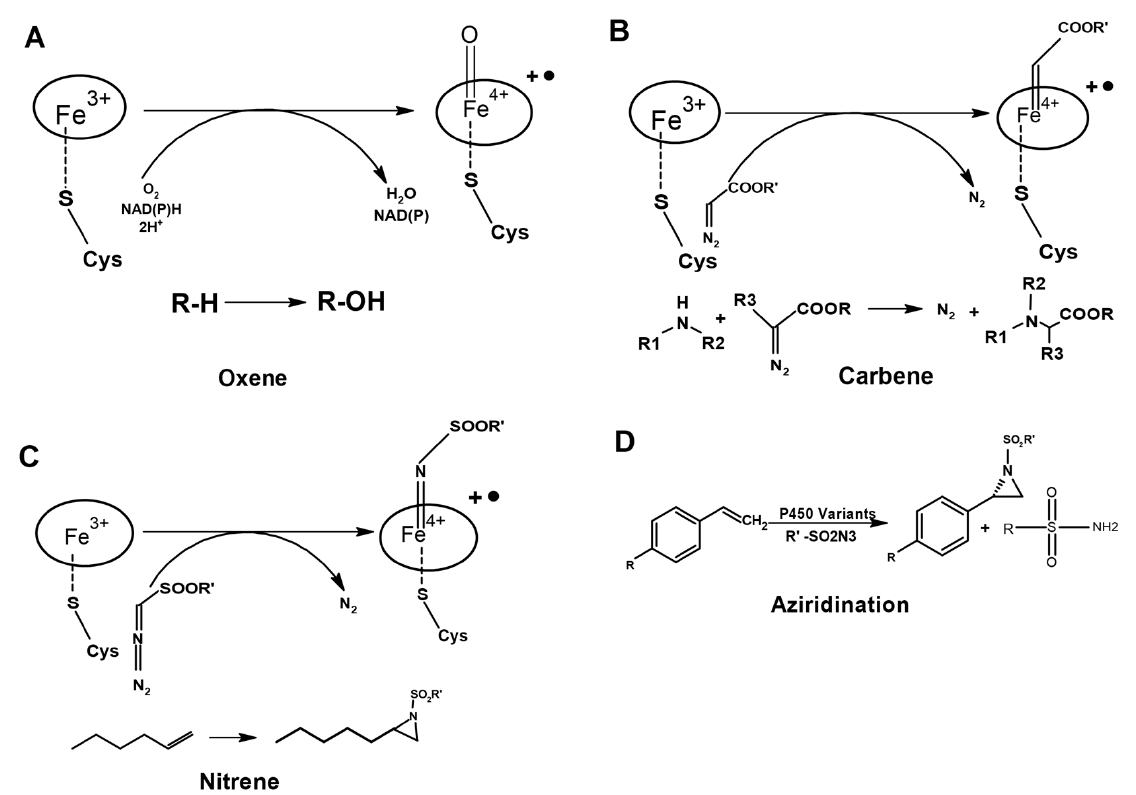
Figure 4. Engineering of P450s for C=C and C-H bond functionalization through abiotic